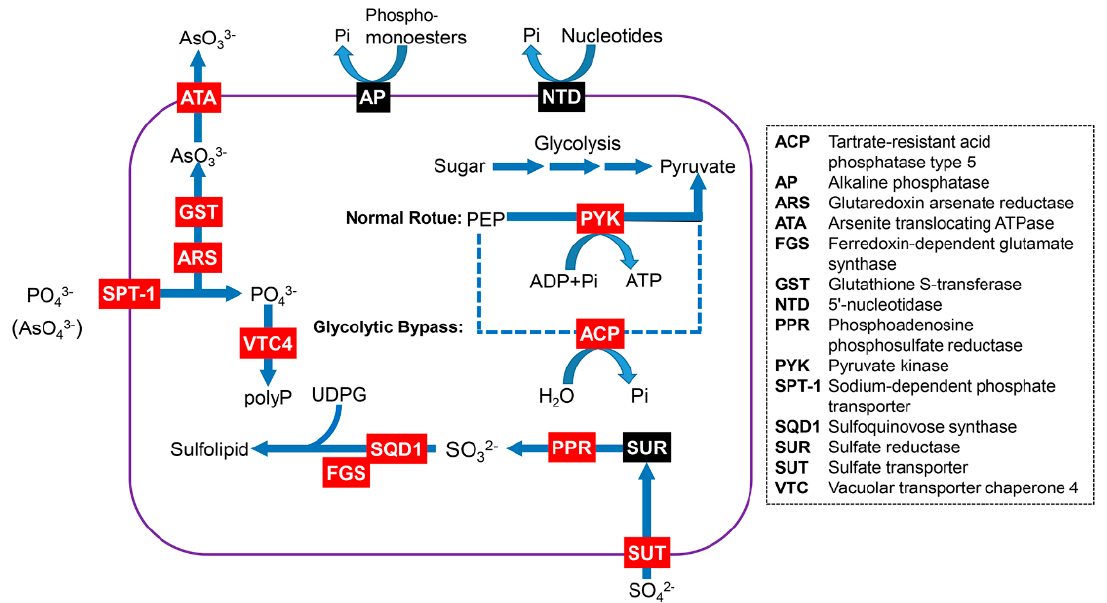
Figure 5. A cell model showing the unigenes of Heterosigma akashiwo that are involved in phosphorus uptake and metabolism. This model was modified from previous studies [35,36] . The red and black boxes represent the unigenes that were detected and not detected, respectively. The detail information of these genes is listed in Table S3.